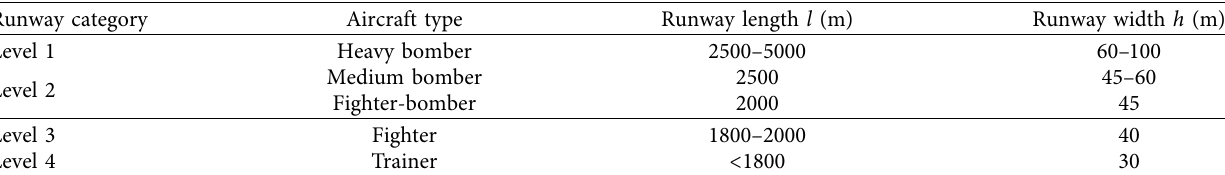
Figure 6: Solution domain graph of the inequality system after processing. (a) Existence of a solution domain and (b) no solution domain. Table 1: Typical data of foreign airport runways.